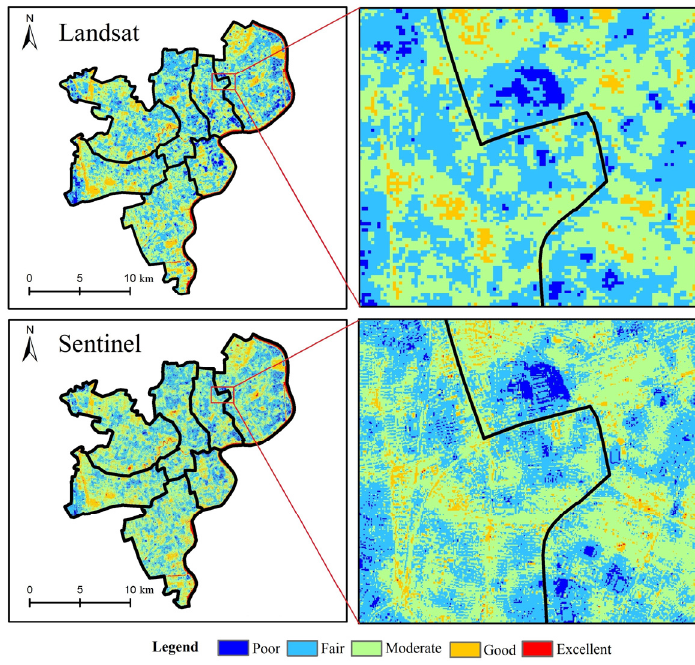
Figure 3. Detailed comparison of RSEI across the different datasets.